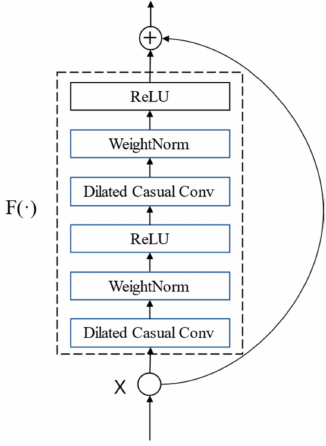
Figure 4. TCN residual